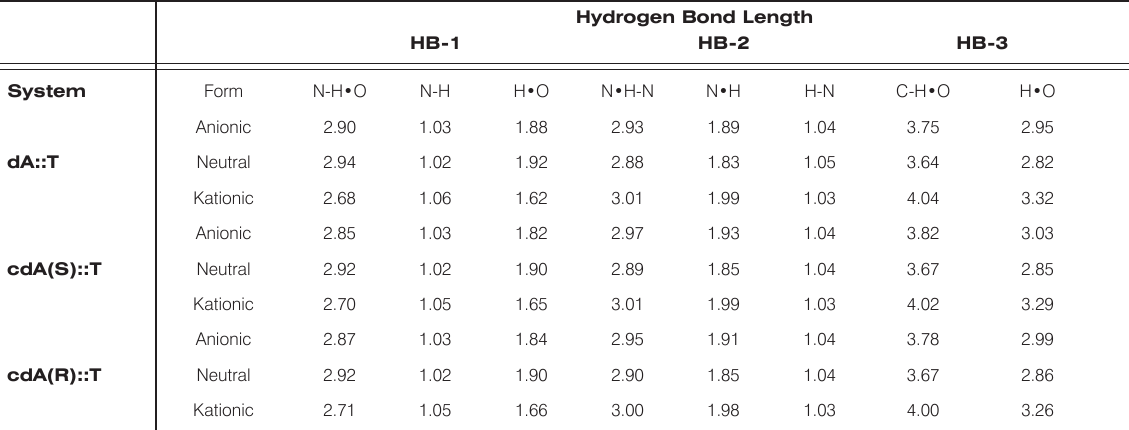
Table 4. Hydrogen Bonds Length [Å] of Neutral, Anionic and Cationic forms of : c dA(S)::T , cdA(R)::T and dA::T nucleosides pairs. DFT calculations on B3LYP/6-31++G**